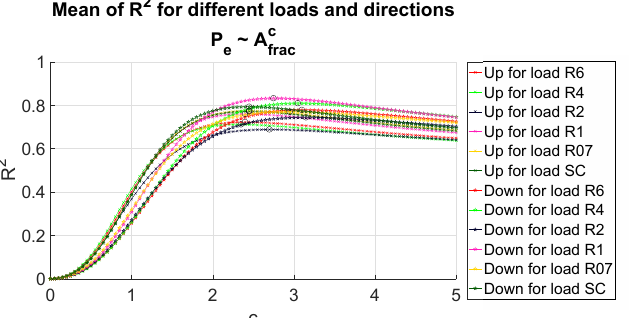
Figure 13. Mean of the coefficient of determination R 2 for different values of c for different loads and directions for the linear regression of P e ∼ A c when the intercept is set to zero. In the legend, frac NL stands for No Load; R6 stands for load 6.6 Ω ; R4 stands for load 4.4 Ω ; R2 stands for load 2.2 Ω ;